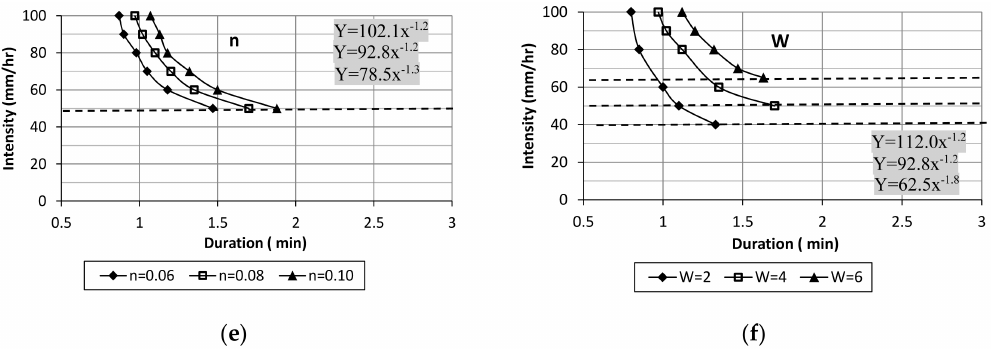
Figure 10. I-D curves for debris flow initiation by Hortonian overland flow in relation to different geometrical and hydrological parameters. The regression formula belong to the curves from top to bottom. For the definition of parameters see Table